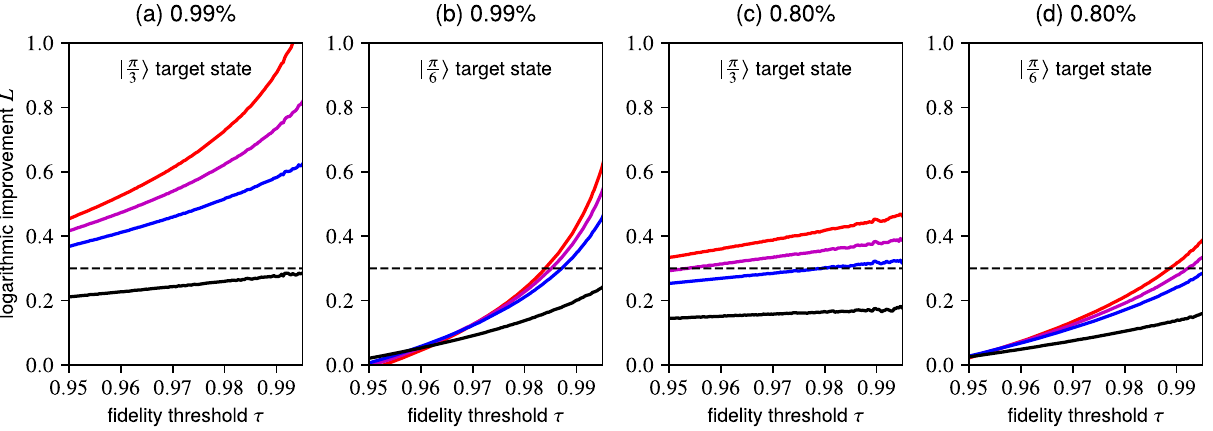
Figure 6. Benchmarking the performance of PNRD and its approximations using APD cascades relative to a single APD detector in preparation of particular superpositions R . The PNRD projection onto ϑ ∈ cascade comprising ten detectors where a single detector clicks ( (cid:31) and black line depicts the case with two detectors ( (cid:31) while considering different transmission efficiencies. In (a) and (c) we aim to prepare π target . In plots (a) and (b) we consider 99% transmission efficiency, while in (c) and (d) we consider mere 6 80% . The horizontal dashed line marks a twofold improvement in each plot. (a) In the high-efficiency regime we (cid:31) (cid:30) obtain roughly tenfold improvement in the high-fidelity preparation of the (cid:31) using more than two detectors offer a significant improvement as well. (b) While the advantage of PNRD is reduced when targeting the state biased towards The PNRD detector and its approximations offer 2-3x higher success probability even in the lower-efficiency scenario. (d) The PNRD detector and its approximations offer roughly twofold In general, conditioning on the PNRD with 99% efficiency the relative improvement is roughly tenfold for The APD cascades comprising ten and five detectors follow. The relative lead of the PNRD diminishes in the 80% efficiency regime. Its advantage also dwindles when we consider target states closer to state. While the cascade comprising two detectors falls short in every case, it still outperforms a single APD, albeit not by a lot.